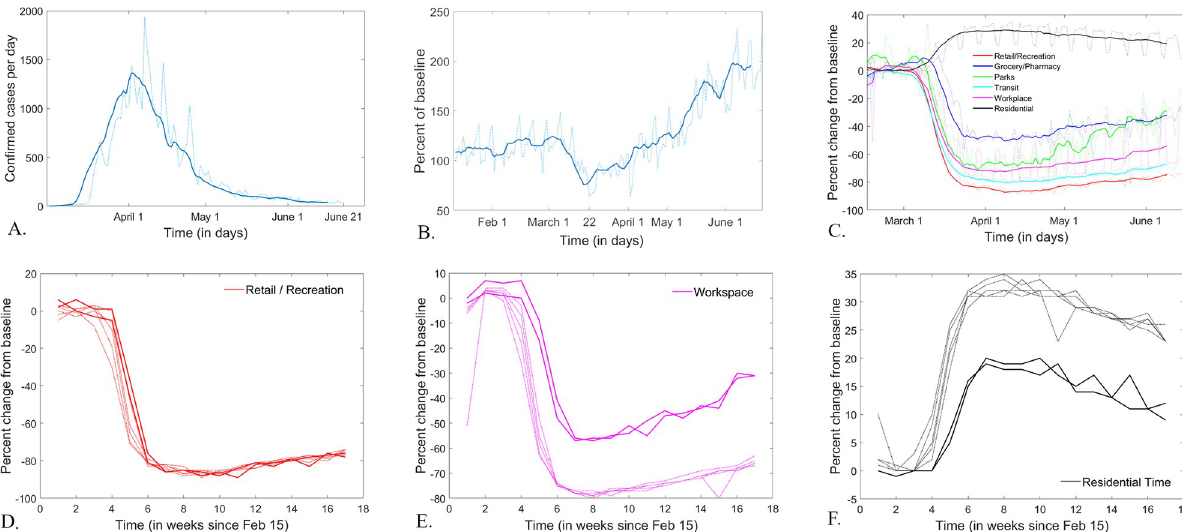
Fig 2. Example of time series and pre-processing, for each data set. A. Example of time series showing the daily incidence of infections, and its windowed smoothing for New York County (i.e., Manhattan). The raw data is represented as a dotted curve; the processed time series obtained by using a seven day average moving window is shown as a solid curve . B. Example of driving time series and window smoothing for Orange county. The raw data is represented as a dotted curve; the processed time series obtained by using a seven day average moving window is shown as a solid curve . C. Example of mobility time series and window smoothing for New York County (i.e., Manhattan). The raw time series are represented as dotted curves: in red for Retail; in blue for Groceries; in green for Parks; in cyan for Transit; in pink for Workspace; in black for Residential. The processed time series obtained by using a seven day average moving window are shown as solid curves, with the same color coding . D-F. Example of weekly mobility time series for Retail ( D , in red), Workspace ( E , in pink) and Residential mobility ( F , in black) in New York County. The Monday-Friday time series are shown as thiner lines, and the weekend time series are shown as thicker lines